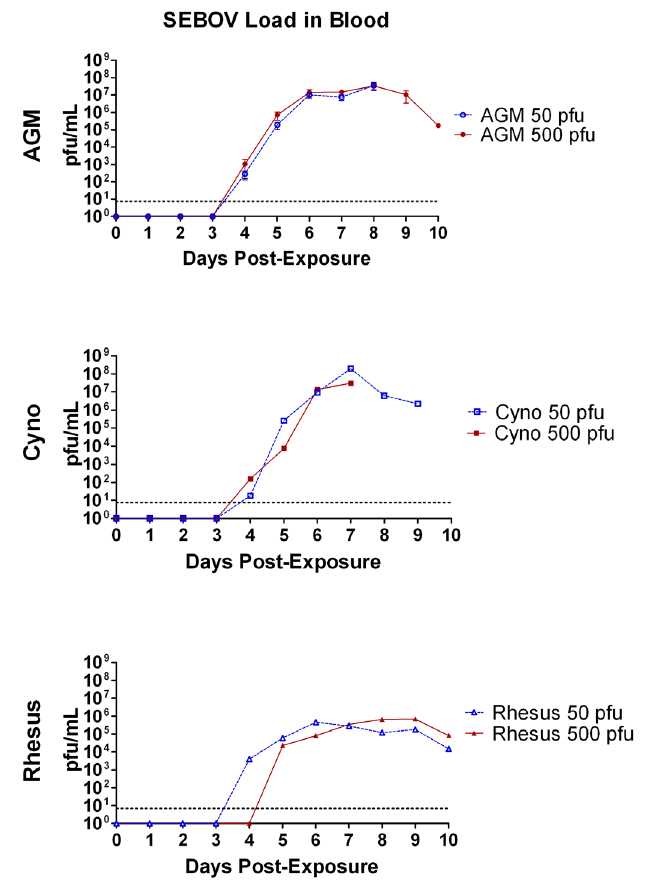
Figure 6. Average SUDV viral load in blood samples drawn daily from NHPs exposed to aerosolized SUDV. SUDV genomes were quantified by real-time RT-PCR and a standard curve was used to report the results in terms of pfu/mL. Graphs are shown for group averages of SUDV pfu/mL of blood drawn each day on the day of (day 0) and following exposure to aerosolized SUDV. There were six animals per group. Error bars represent the standard error of the mean. Rhesus peak viral load was significantly less than AGMs ( p <0.01) but not